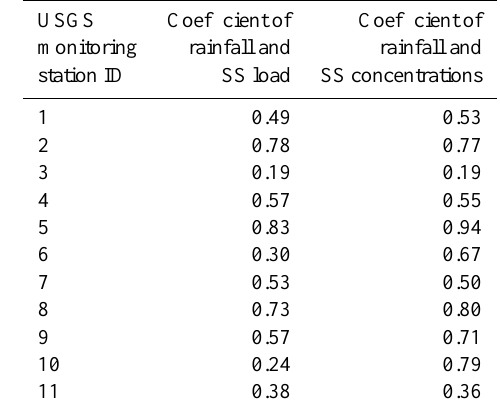
Table 6. Rainfall and SS load/concentration correlation coeffi-